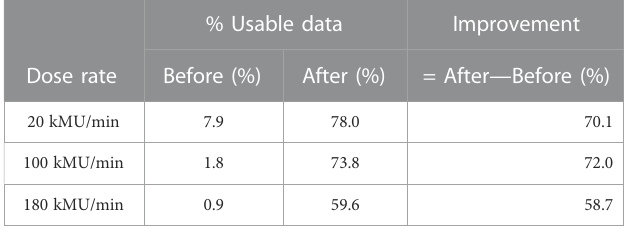
TABLE 3 Given 100,000 PG scatterings detected by the Compton camera and the rate of Compton camera event misdetection, what percentage of the detected data is usable for PG image reconstruction before and after using the NN for event correction at varying dose